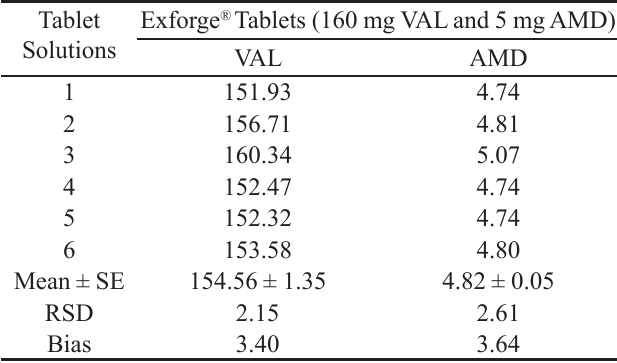
TABLE III - Assay of AMD and VAL from its tablet dosage form Tablet Solutions